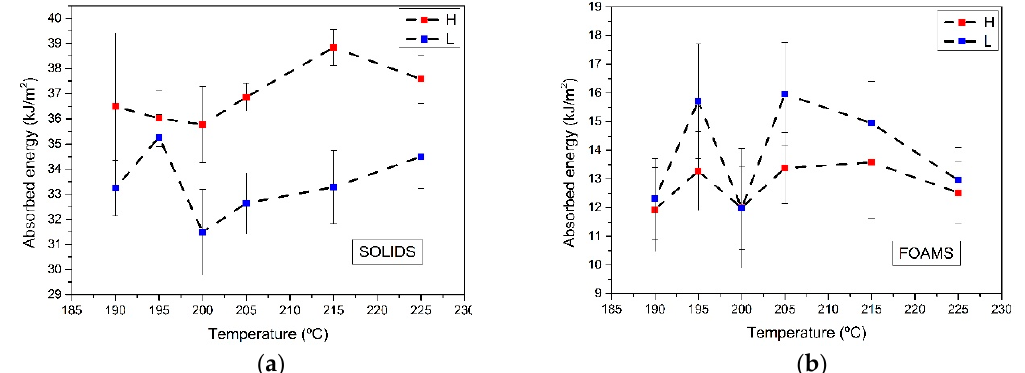
Figure 2. Absorbed energy in the Izod impact test for ( a ) solid and ( b ) foamed samples.